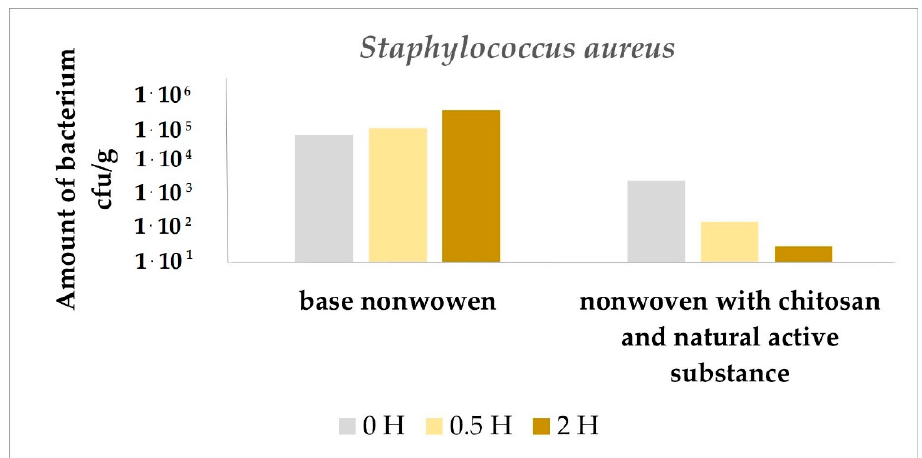
Figure 3. Effect of influence of chitosan on biodegradable nonwoven for microorganisms.